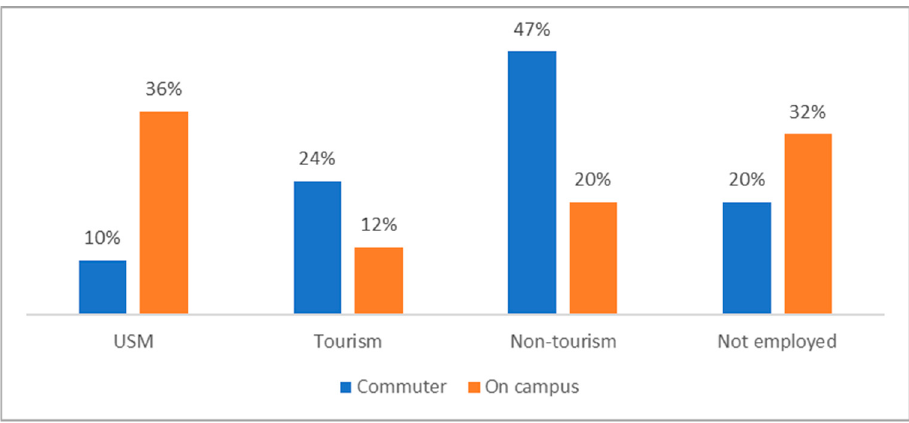
Figure 1. Residential status by current employment.